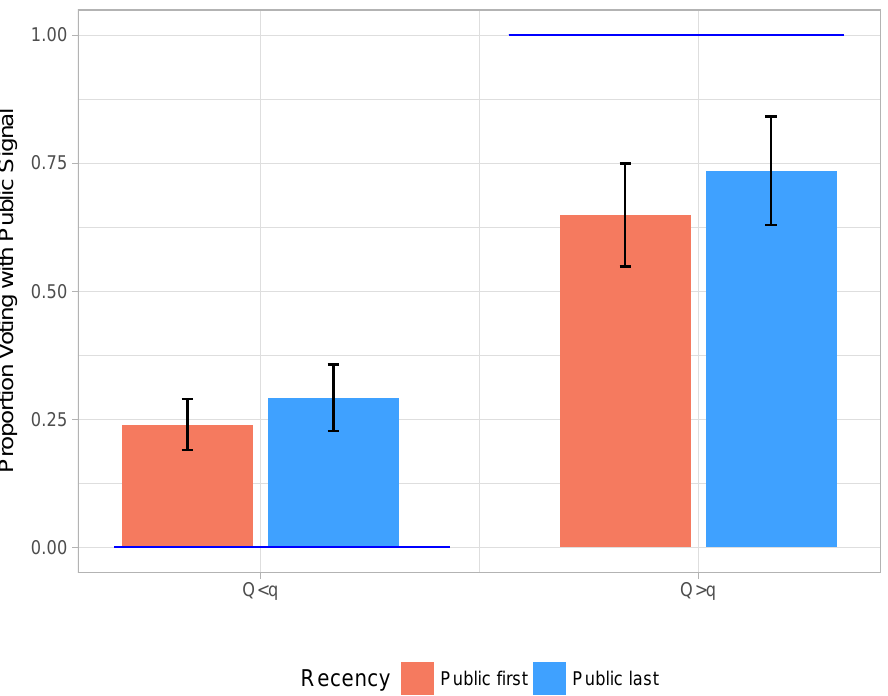
Figure A2. Recency effects in individual sessions. Average fraction of votes with public signal under mismatch and 95% confidence intervals. Standard errors are clustered at the individual level. Blue lines represent the unique optimal decision in the individual treatment (follow the more precise signal).